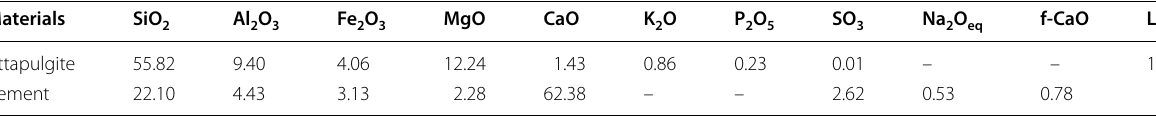
Table 1 Chemical composition of attapulgite and cement ( wt %).